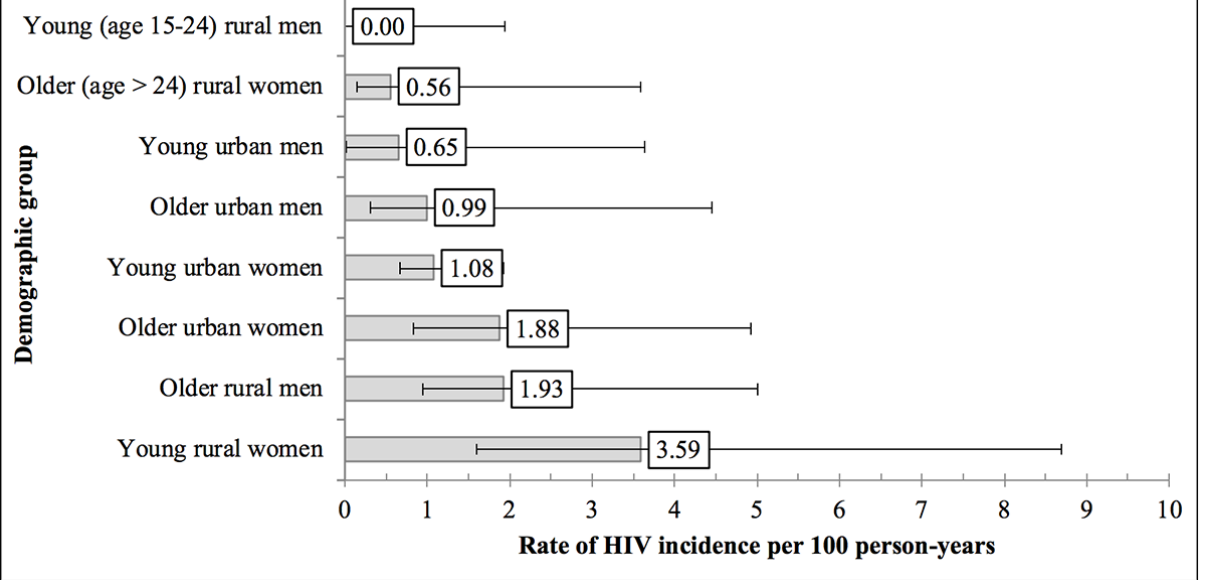
Figure 2. HIV incidence per 100 person-years by age, residence, and sex; household cohort of adults age ≥ 15 years in the Zambezi region of Namibia, 2014-2016 (N=1624). Error bars in the figure represent two-sided 95% CI, except when there were 0 seroconversions, in which case CI are one-sided and